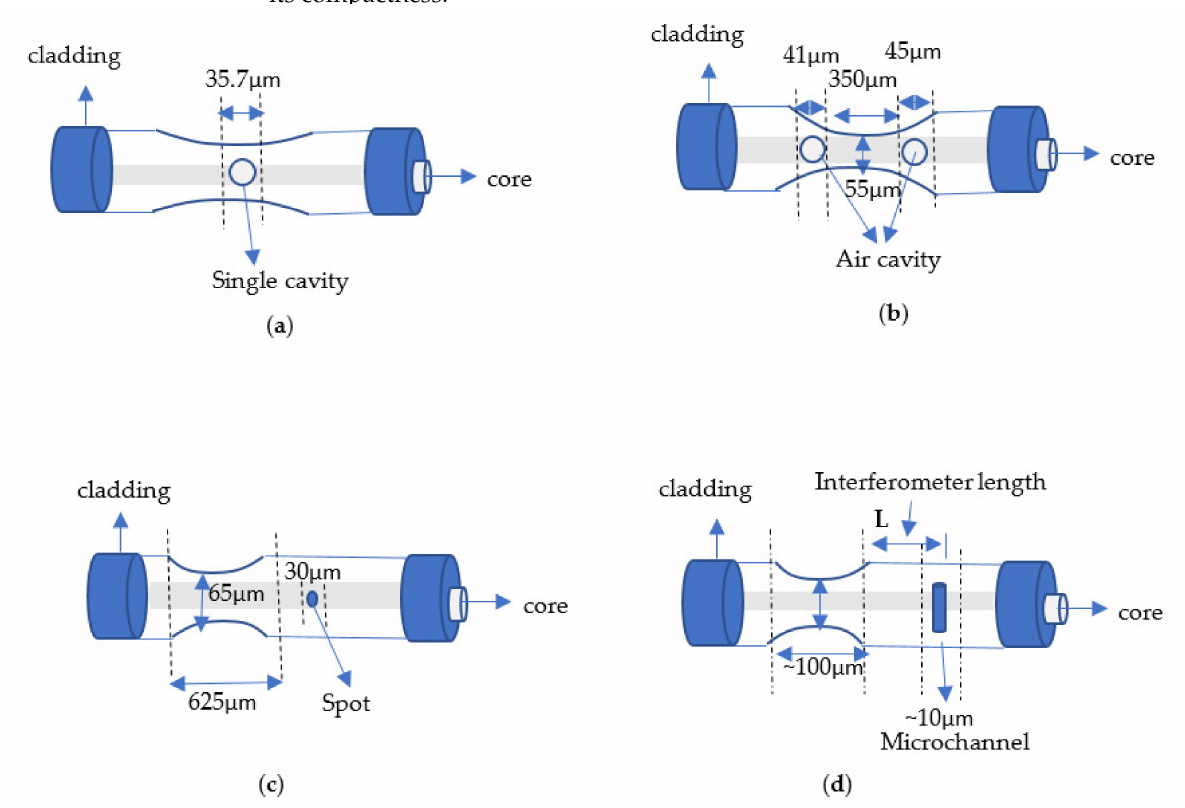
Figure 5. Tapered fiber based on Mach–Zehnder (MZI) structures. ( a ) Illustration of tapered based on single cavity [82]. ( b ) Illustration of tapered based on double air cavities [87]. ( c ) Illustration of tapered based on air cavity and spot [90]. ( d ) Illustration tapered based on single air cavity/channel